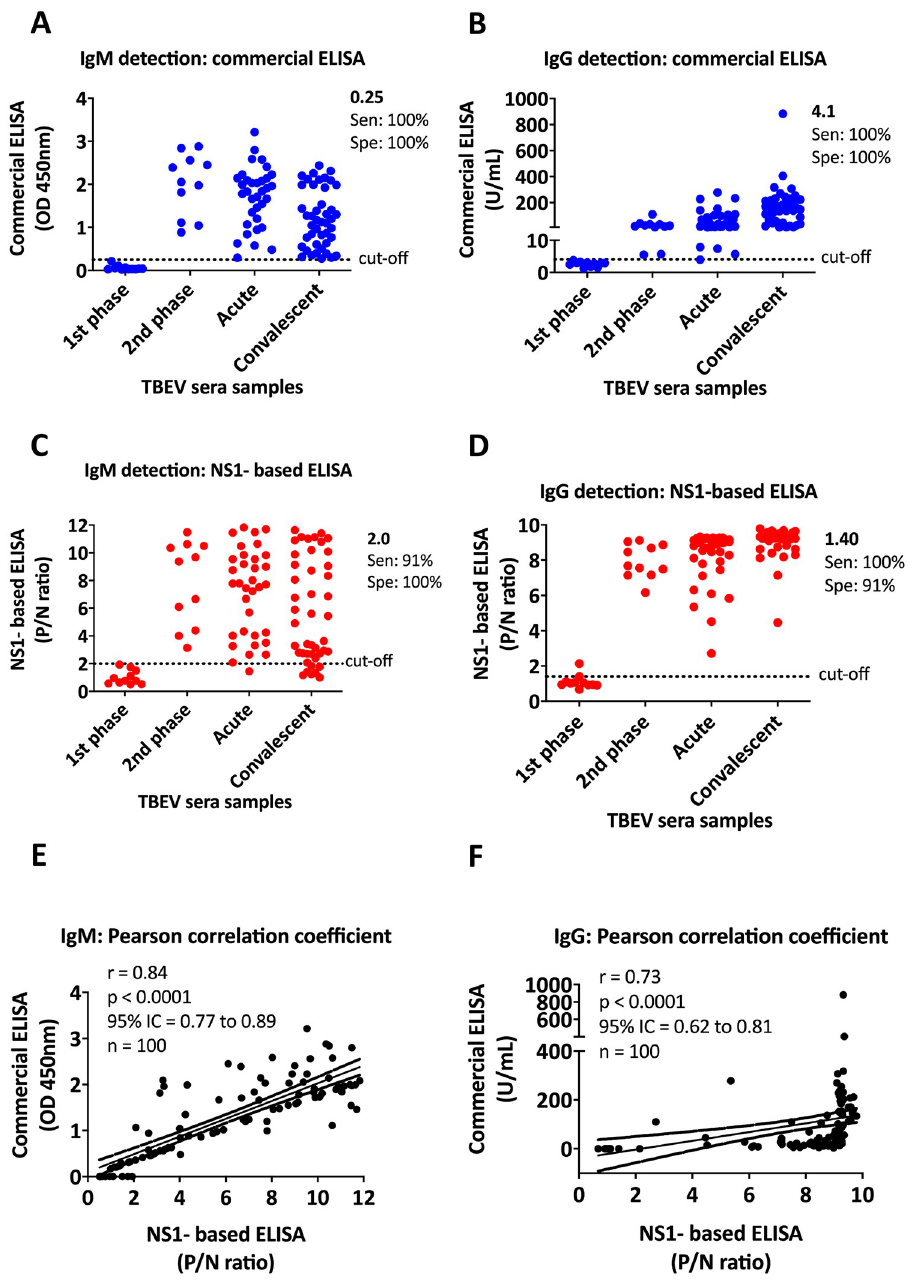
Fig 3. Detection of IgM/IgG antibodies from TBEV infected individuals. A and B) Detection of IgM (A) IgG (B) antibodies by commercial ELISA. IgM results are reported as OD 450 , while IgG results are reported as U/mL. Cut-off values for IgM (0.25) and IgG (4.1) were calculated according to the manufacturer’s instructions. C and D) Detection of IgM (C) IgG (D) antibodies by TBEV rNS1-based ELISA. Optimal cut-off values of the P/N ratio (OD 450 of test specimen divided by the mean OD 450 of negative control specimens) were calculated based on the comparative receiver operating characteristic (ROC) curve analysis. Cut-off values for IgM and IgG fell at 2.0 and 1.40, respectively. E and F) Correlation between commercial and TBEV rNS1-based ELISA assays. The two-tailed Pearson’s correlation value (r) was calculated for IgM and IgG values. A P value of < 0.0001 rejected the null hypothesis that there exists no correlation between commercial and rNS1-based ELISA methods. 95% Interval Confidence (IC) value is also indicated and showed in dotted lines above and under the linear correlation. 100 sera samples (n) from different phases of TBEV infection were included in the analysis. � each ELISA result includes the average of two biological